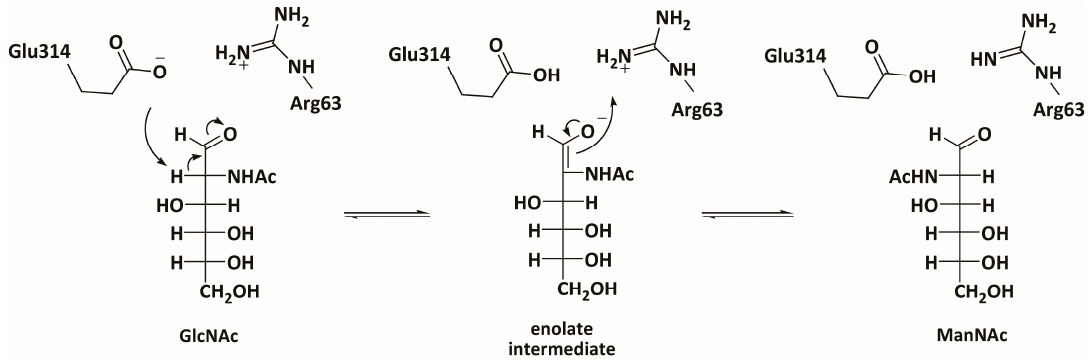
Figure 6. Deprotonation/reprotonation mechanism model of PhGn2E. Glu314 is able to deprotonate and protonate C ‐ 2 of GlcNAc while Arg63 is the responsible of the deprotonation and protonation in C ‐ 2 of ManNAc.